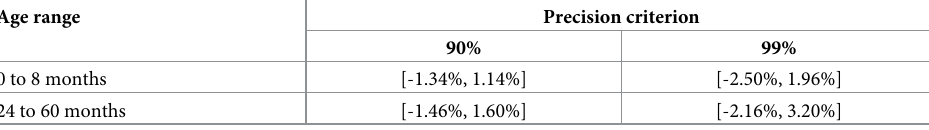
These values were estimated with the Under-5 Mortality Database (U5MD) vital records from which the k-model is derived.